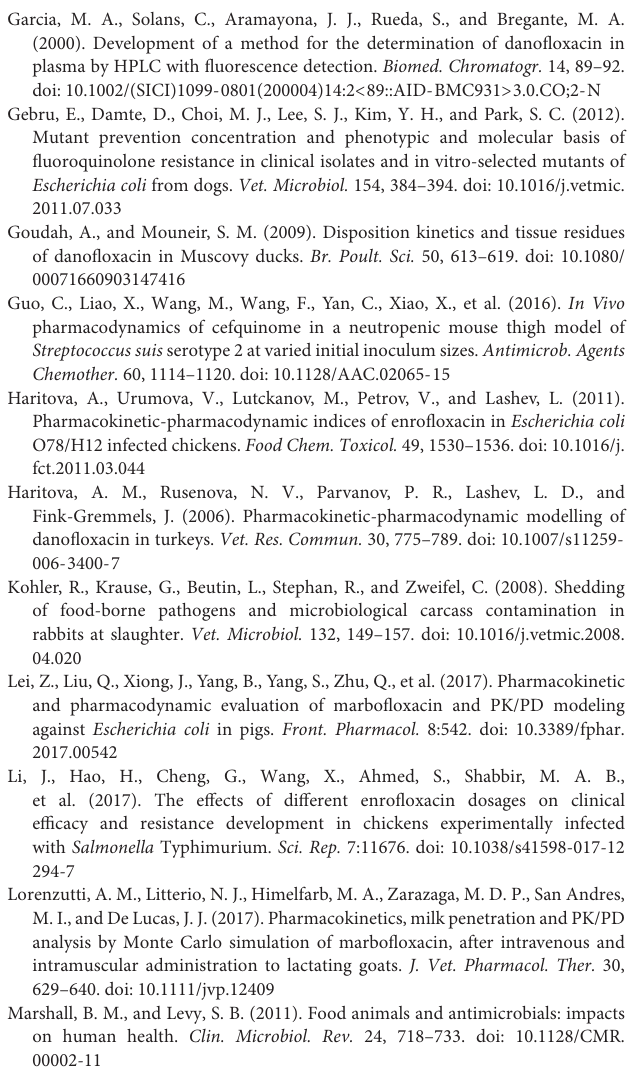
FIGURE S1 | Chromatograms of blank rabbit serum (A) and blank rabbit serum spiked at the level of 0.02 g/mL (B)